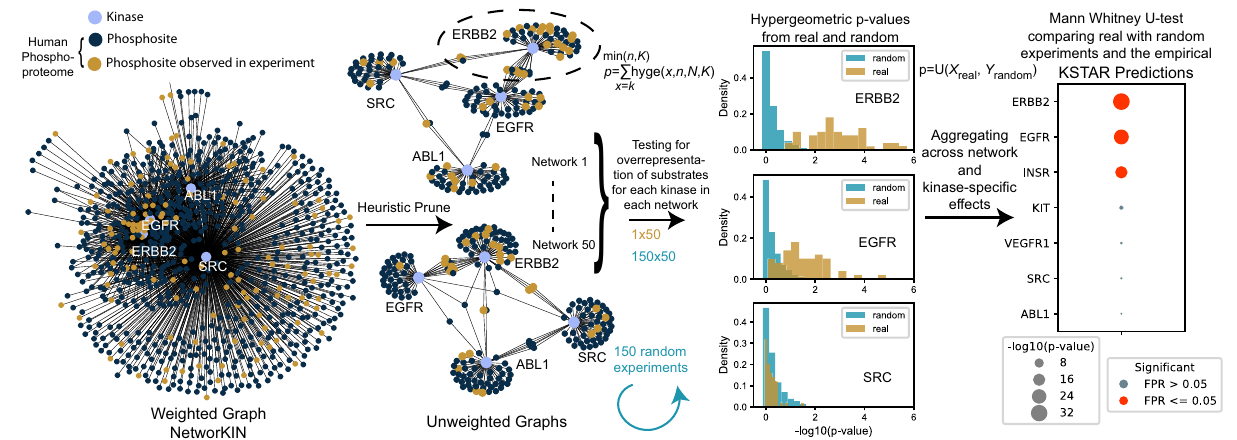
Fig. 1 | Overview of KSTAR algorithm. First, we heuristically prune dense and highlyoverlapping weighted kinase-substrate prediction graphs from NetworKIN 24 into many sparse, binary graphs. Statistical enrichment is calculated for an experiment that has a de fi ned set of phosphorylation sites for every kinase across all networks using a hypergeometric distribution. We generate and calculate enrichmentin150randomexperimentsusingthesameapproach.Next,weusethe Mann-WhitneyUtesttomeasurethelikelihood thattheenrichment p -valuesinthe realexperimentaremoresigni fi cantthantherandomexperiments,givingusa fi nal p -value, which accounts for the underlying enrichment of substrates in a network, aggregates that information across the different network con fi gurations, and